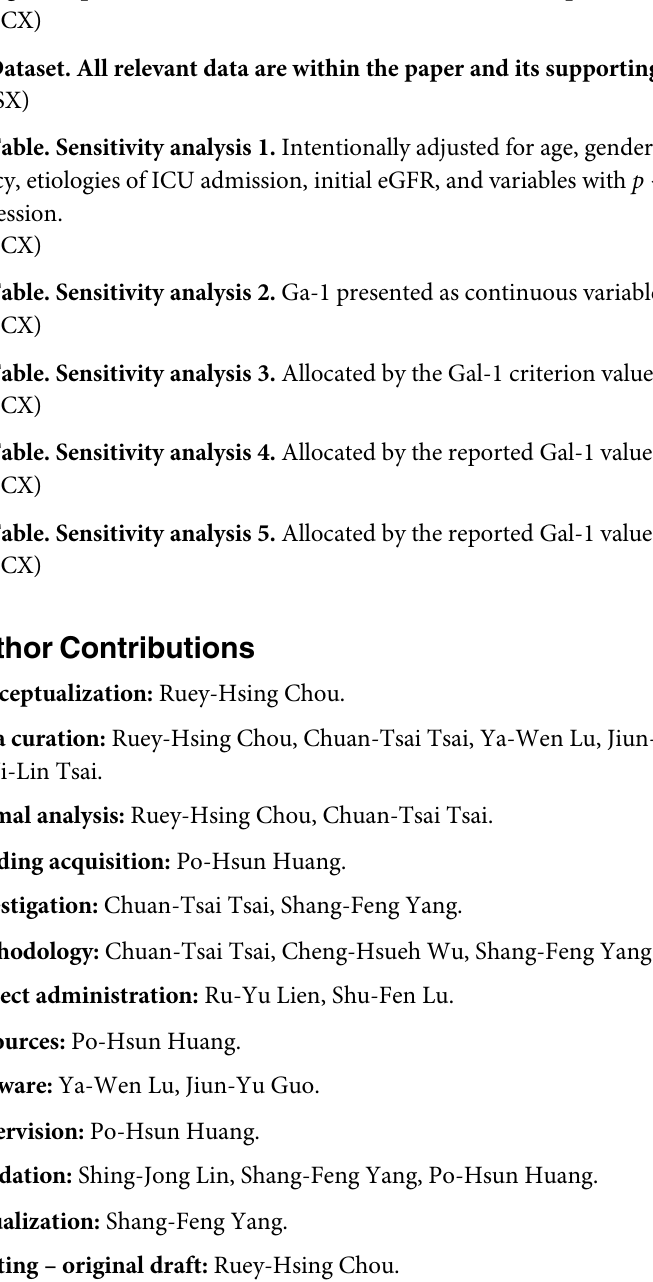
S1 Fig. ROC curve of serum Gal-1 value in prediction the 90-days mortality. S2 Fig. Comparison of serum Gal-1 value between the ICU patients and control. S1 Dataset. All relevant data are within the paper and its supporting information files. S1 Table. Sensitivity analysis 1. Intentionally adjusted for age, gender, heart failure, malig- nancy, etiologies of ICU admission, initial eGFR, and variables with p < 0.05 in the univariate regression. S2 Table. Sensitivity analysis 2. Ga-1 presented as continuous variable. S3 Table. Sensitivity analysis 3. Allocated by the Gal-1 criterion value of ROC curve. S4 Table. Sensitivity analysis 4. Allocated by the reported Gal-1 value of viral infection. S5 Table. Sensitivity analysis 5. Allocated by the reported Gal-1 value of bacterial